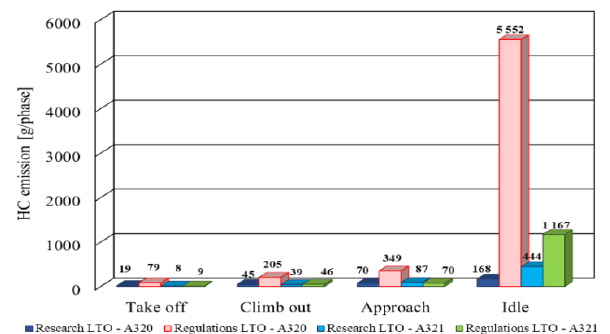
Fig. 13. CO emission for Airbus A320 and A321 in regulations and adopt- ed LTO cycle in each phase